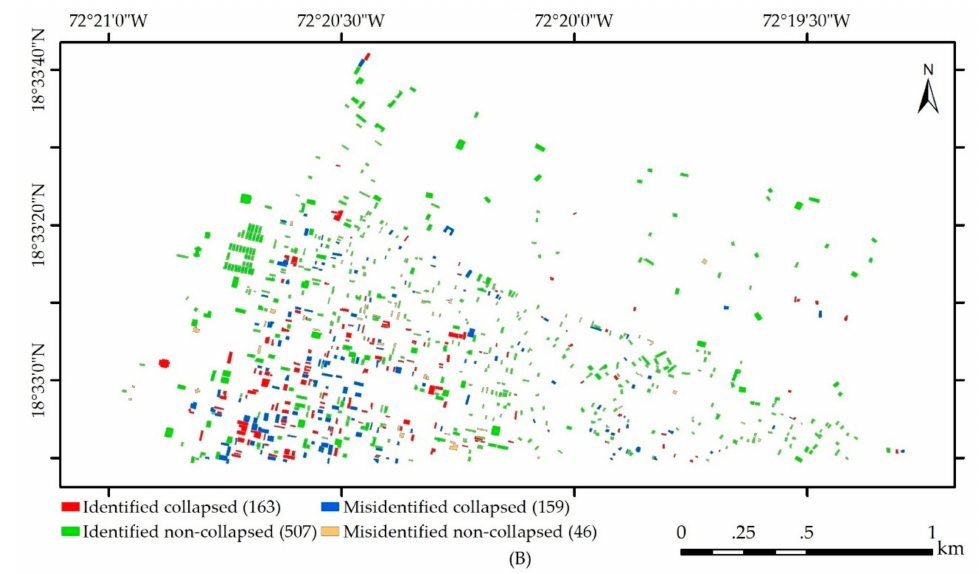
Figure 7. The performance of the CNN on identifying collapsed buildings using test A ( A ) and test B ( B ) dataset.